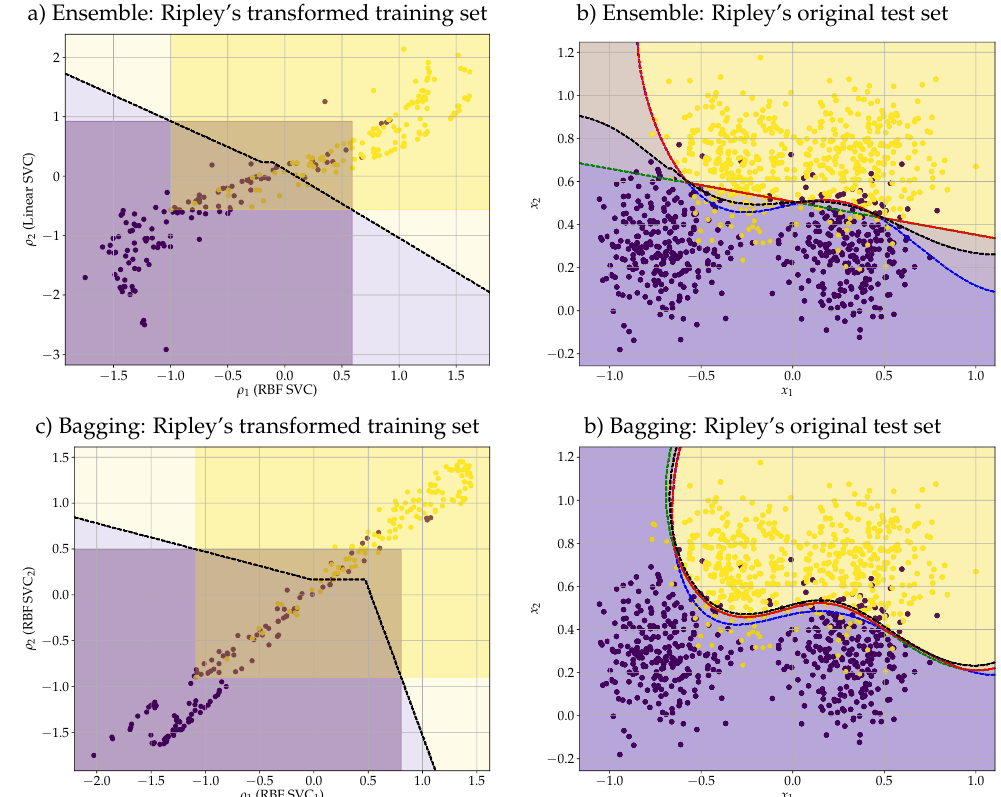
Figure 3. Performance of ensemble and bagging reduced dilation-erosion (r-DEP) classifiers on Ripley’s dataset (see Example 6). ( a ) and ( c ) show the scatter plot of transformed training data, the regions D ( w ) and E ( m ) , and the decision boundary of the DEP classifier. ( b ) and ( d ) depict the scatter plot of the original test data and the decision boundary of r-DEP (black) and other binary